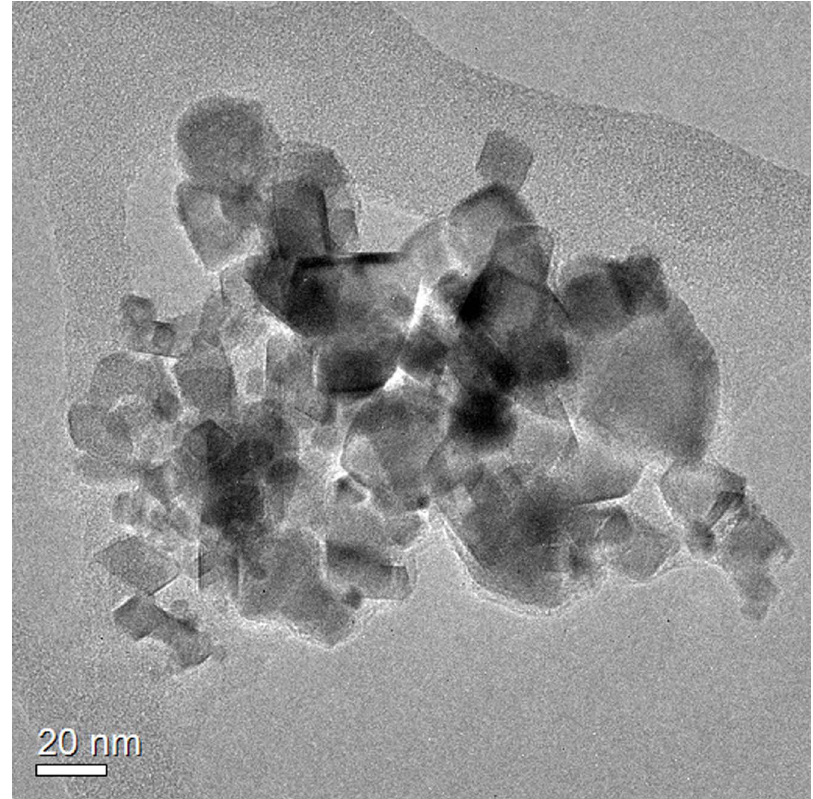
Figure 2. TEM bright field image of CeO 2 NP after 24 h of stirring (5 mg/L, pH 7.6, 2 mM NaHCO 3 ).